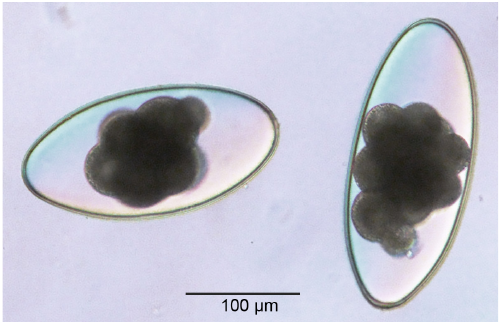
Figure 1. Nomarski interference contrast photomicro- graph of two Nematodirella longissimespiculata eggs from feces of an Ameralik caribou calf (mixed native caribou and semi-domestic Norwegian reindeer) of West Green- land. The ellipse eggs have a thin smooth surfaced chitin- ous shell, rather sharp poles and similar side-walls. Eight dark-staining blastomeres are separated from the yolk membrane by a wide fluid-filled cavity. Bar = 100